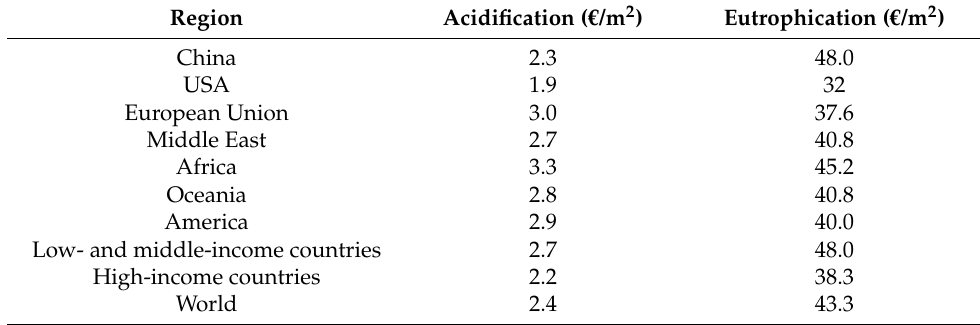
Table 5. Environmental impact cost over 50